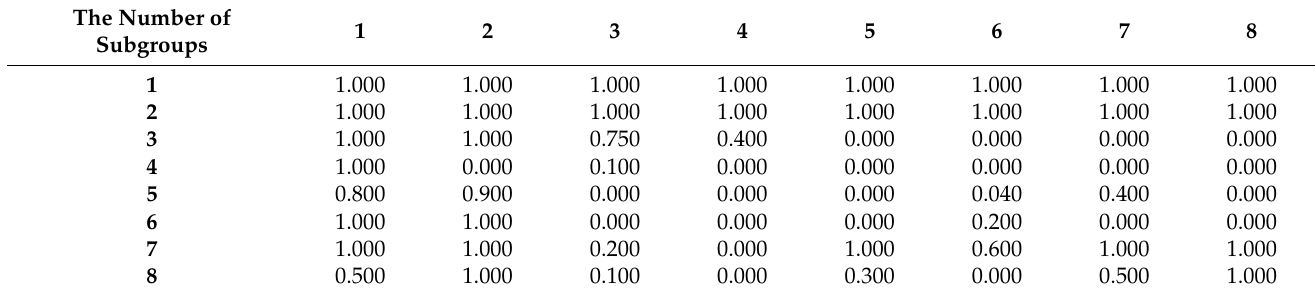
Table 4. Cohesive subgroup density matrix in 2020.